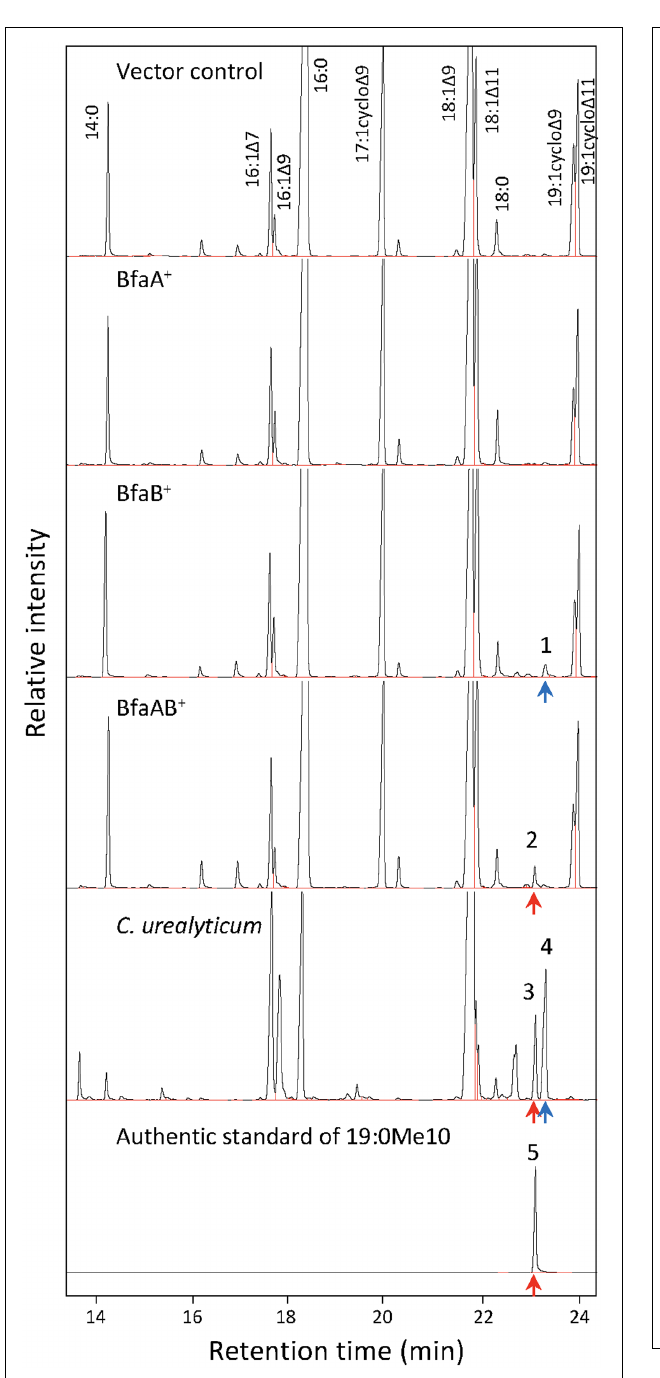
of 19:0Me10. To evaluate the possibility that the third gene product is involved in the formation of 19:0Me10, we expressed the gene for polyketide cyclase together with the bfaA and bfaB genes in E. coli cells using the plasmid pFADO-M2121- PCYC (Supplementary Figure 1). However, the abundance of mBFA in the cells was not altered compared with that in the cells expressing the bfaA and bfaB genes (data not shown), indicating that the third gene located upstream of the bfaA and bfaB genes does not seem to be an